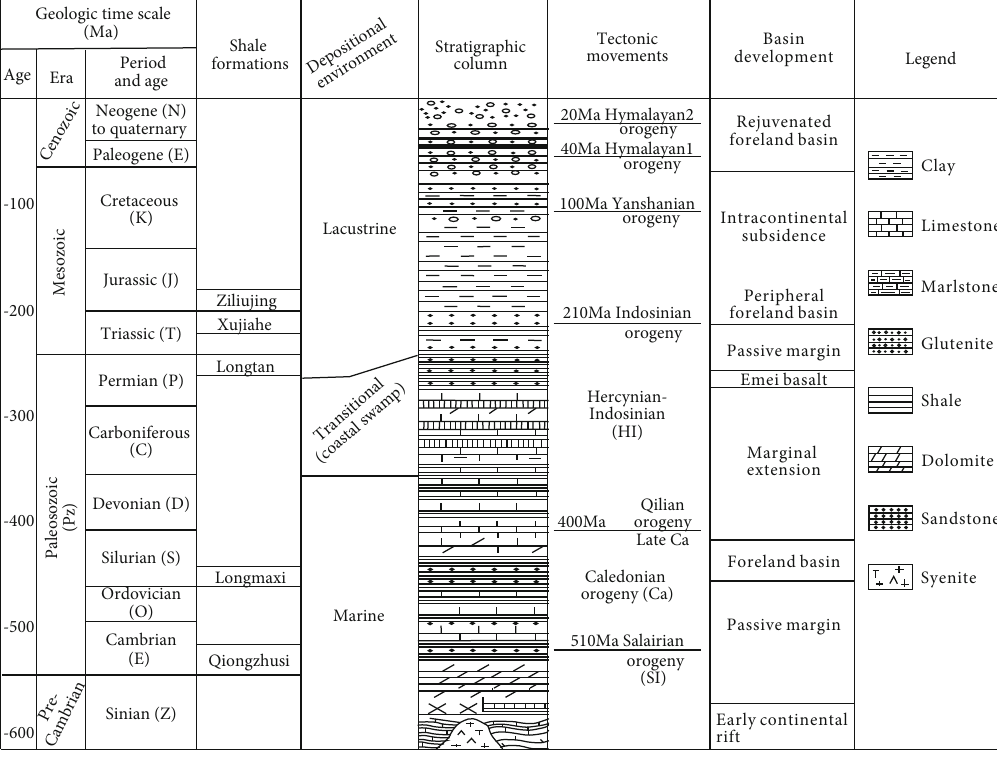
Figure 2: Structural evolution and Stratigraphic histogram of Sichuan Basin. The Qiongzhusi Formation, Wufeng Formation, Longmaxi Formation, Longtan Formation, Xujiahe Formation, and Ziliujing Formation shales are primarily developed in the Sichuan